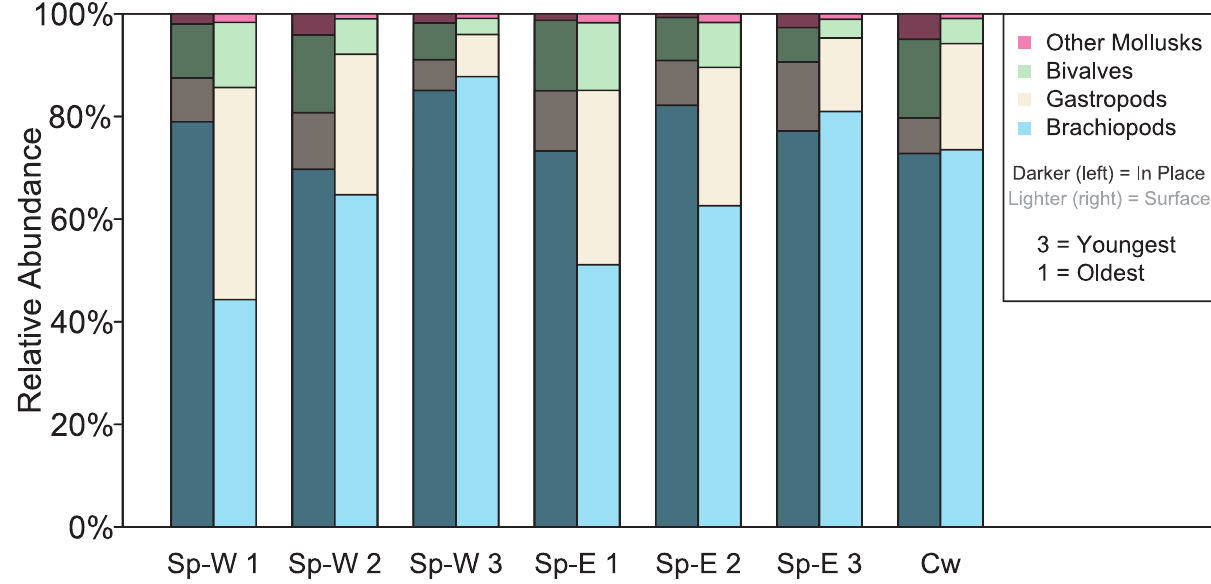
Fig 5. Relative abundance: In-place versus surface. Relative abundance of major taxonomic groups compared between the in-place and surface samples. SpE = Spillway East outcrop, SpW = Spillway West outcrop, CW = Causeway Road outcrop. The lower the number, the lower stratigraphic